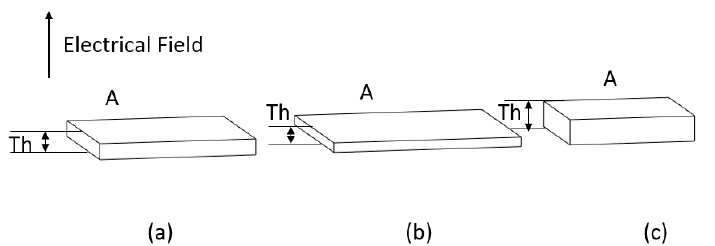
Figure 1. Illustration of the PVDF response to an applied electrical field ( a ) piezoelectric PVDF under no electrical field. ( b ) PVDF sheet under an electrical field with the opposite direction to the polling direction ( c ) PVDF sheet under electrical field with the same direction as the polling direction.